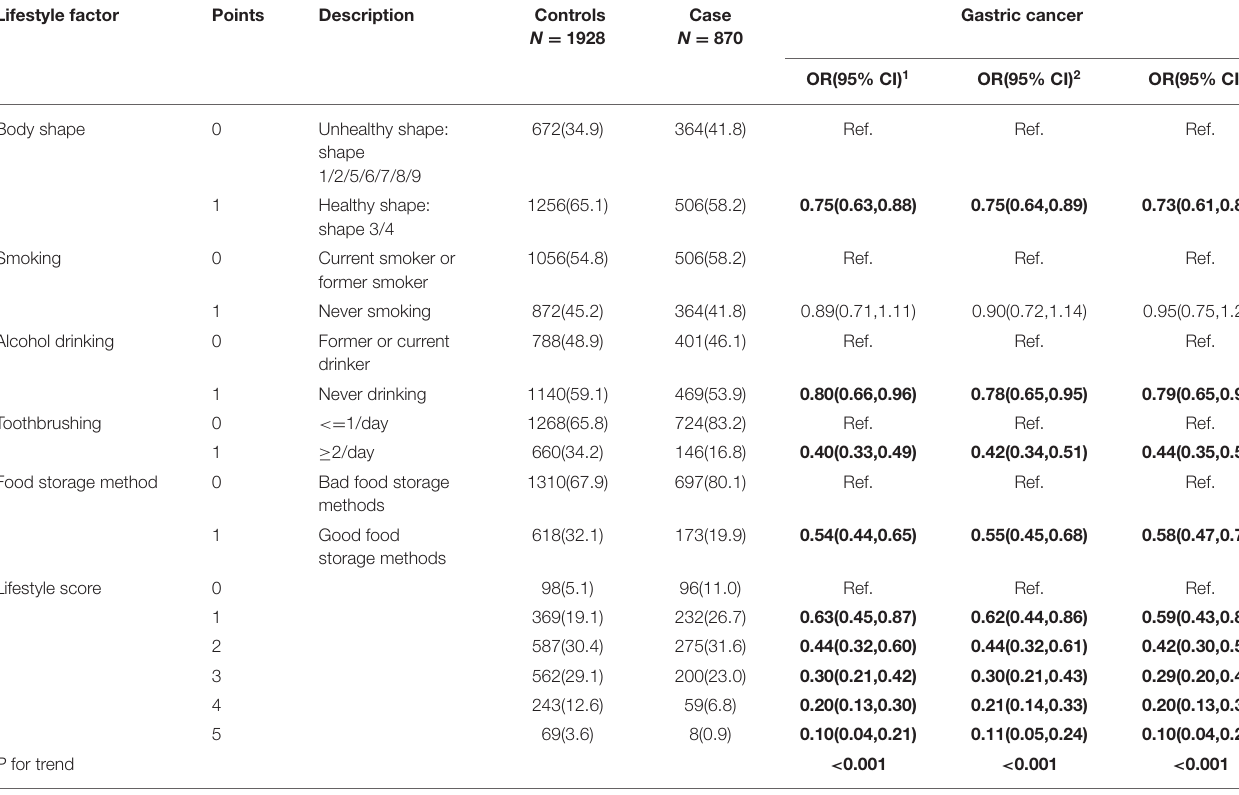
TABLE 2 | The association between lifestyle factors, lifestyle score and the risk of gastric cancer. Lifestyle factor